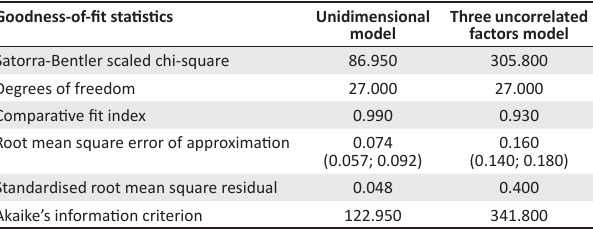
TABLE 5: Goodness-of-fit statistics for the competing measurement models (ASLQ, n = 405). Goodness-of-fit statistics